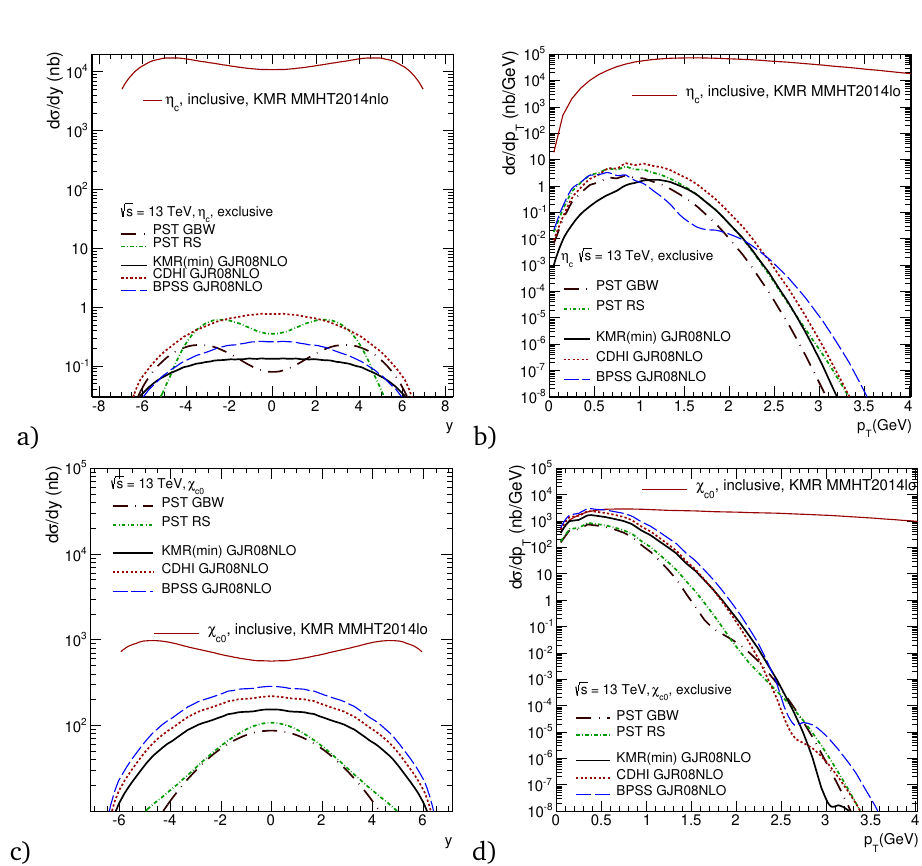
Figure 2: a) Rapidity dependent cross section and b) transverse momentum depen- dent cross section for η CEP for various UGD prescriptions; c) & d): the analogous c cross sections for χ CEP. Also shown are the cross sections for the relevant inclusive c 0 (nondiffractive) cross section.